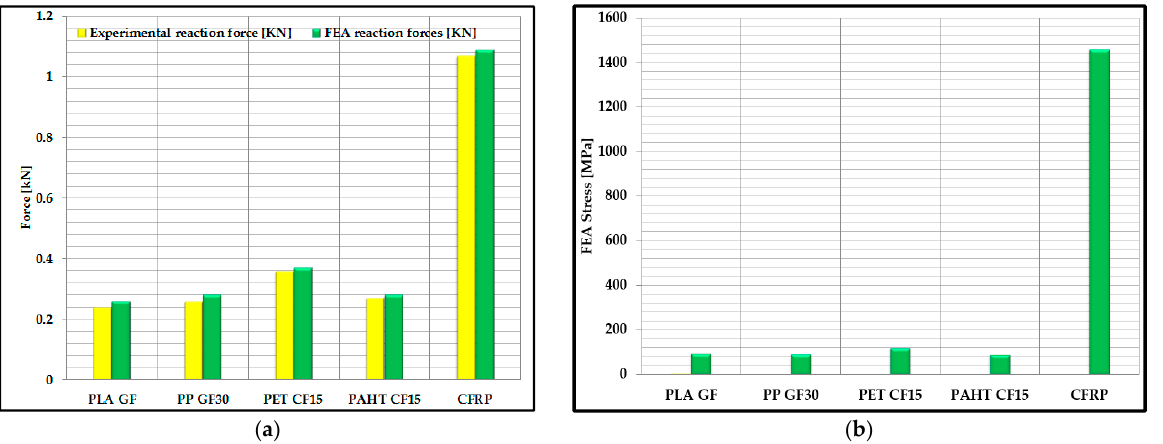
Figure 7. Comparative study of experimental results and FEA results: ( a ) graphical representation of reaction forces; ( b ) graphical representation of FEA